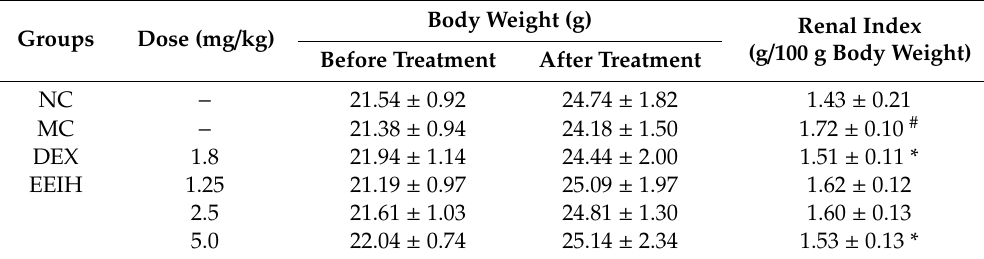
Table 2. E ff ects of the ethanol extract of Illicium henryi (EEIH) on body weight and renal index of lipopolysaccharide (LPS)-treated mice. Groups Dose (mg / kg)